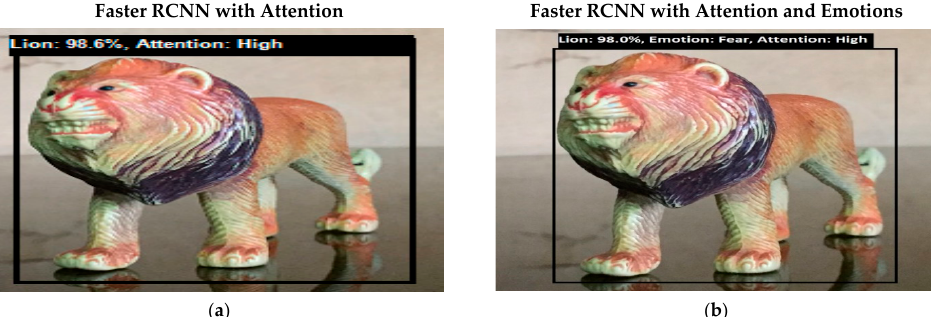
Figure 5. ( a ) Bottom-up attention-based object recognition without internal emotions. Now the system is fully focused on the lion object. ( b ) Bottom-up attention-based object recognition with the system’s internal emotions. Initially, the emotions of the system were normal, but as the system recognizes a given object, its emotions change to fear. Fear is a strong emotional state, so it regulates a medium level of attention to a high level.